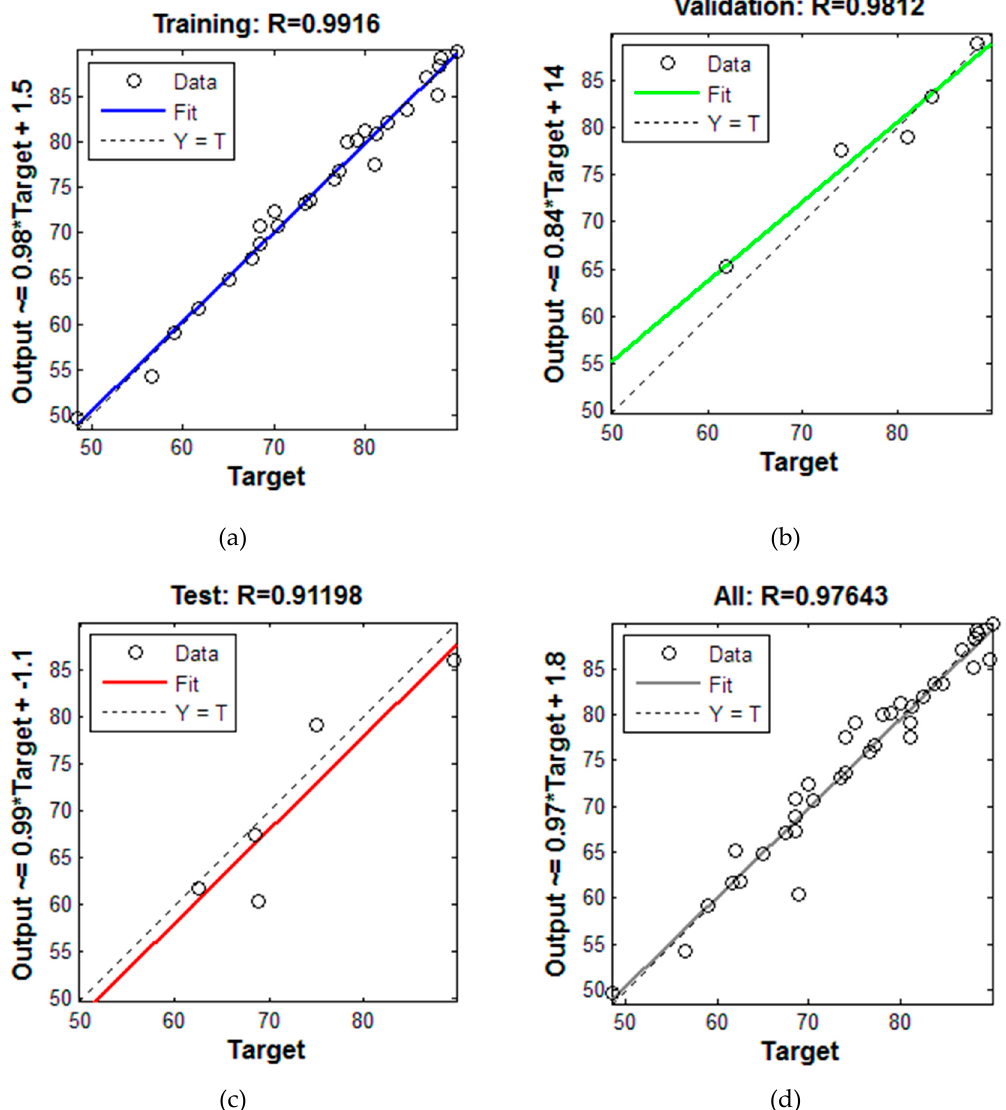
Figure 11. Results based on the correlation coefficient of thermal conductivity ratio. ( a ) Training, ( b ) Validation, ( c ) Test, ( d ) totally).